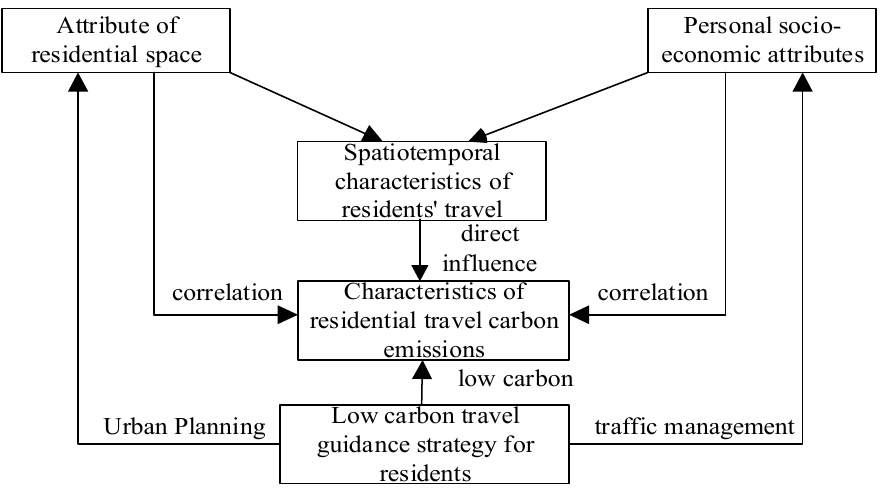
Table 3. CO 2 emission intensity by transport modes (g/person.km).